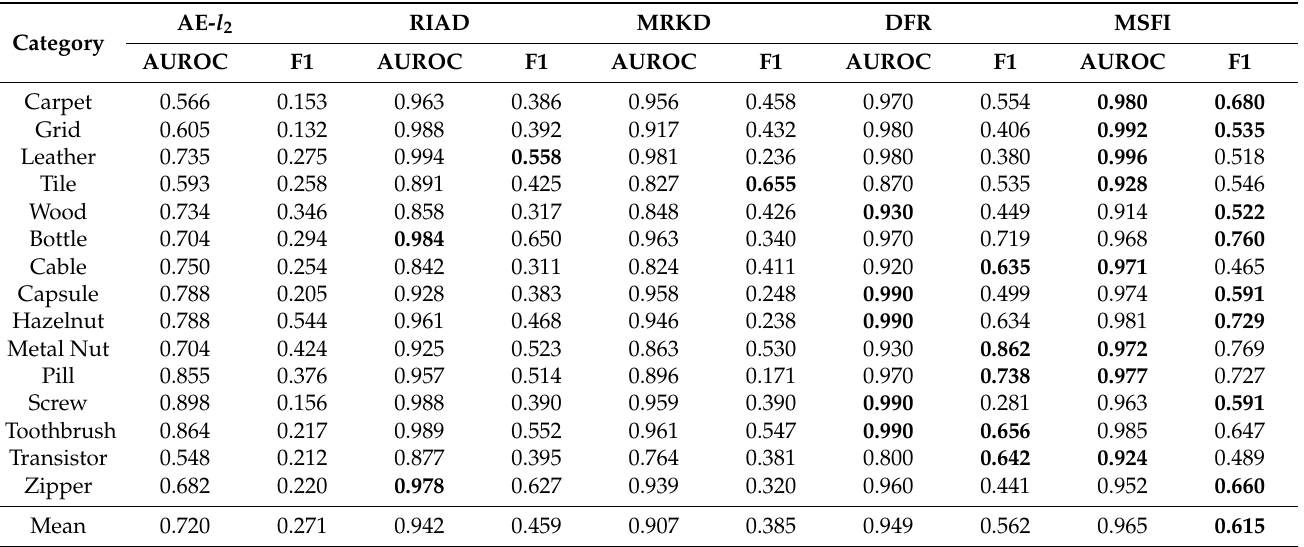
Table 3. The anomaly localization results on MVTec AD dataset. The best result for each class is bolded.